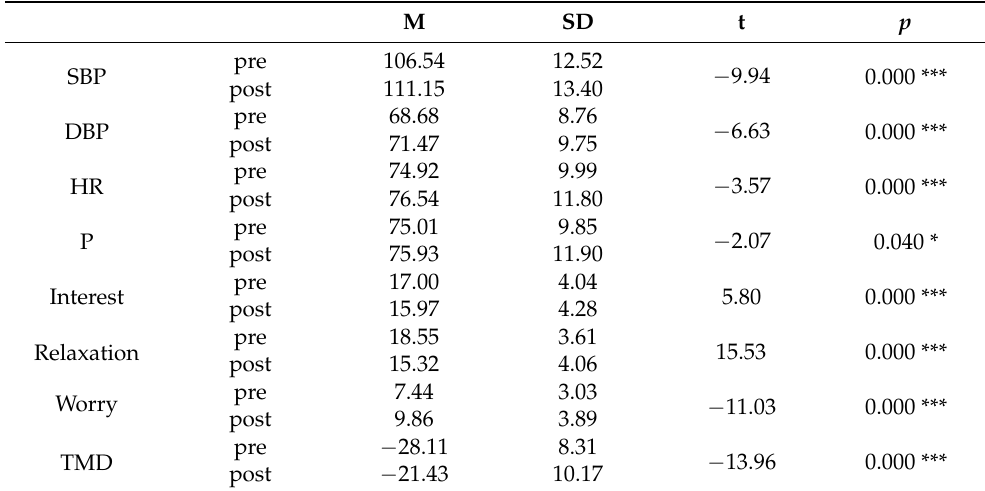
Table 4. Pairwise comparison of pre-TSST and post-TSST.